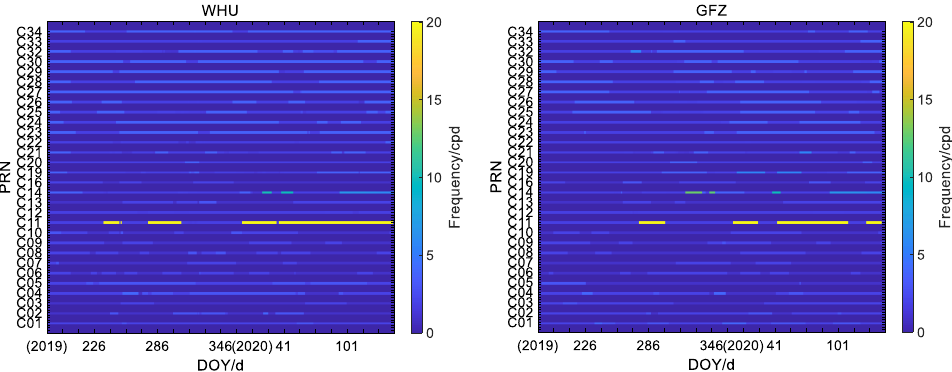
Figure 6. The frequency variations of main periodic term for WHU (left) and GFZ (right) clock offsets.